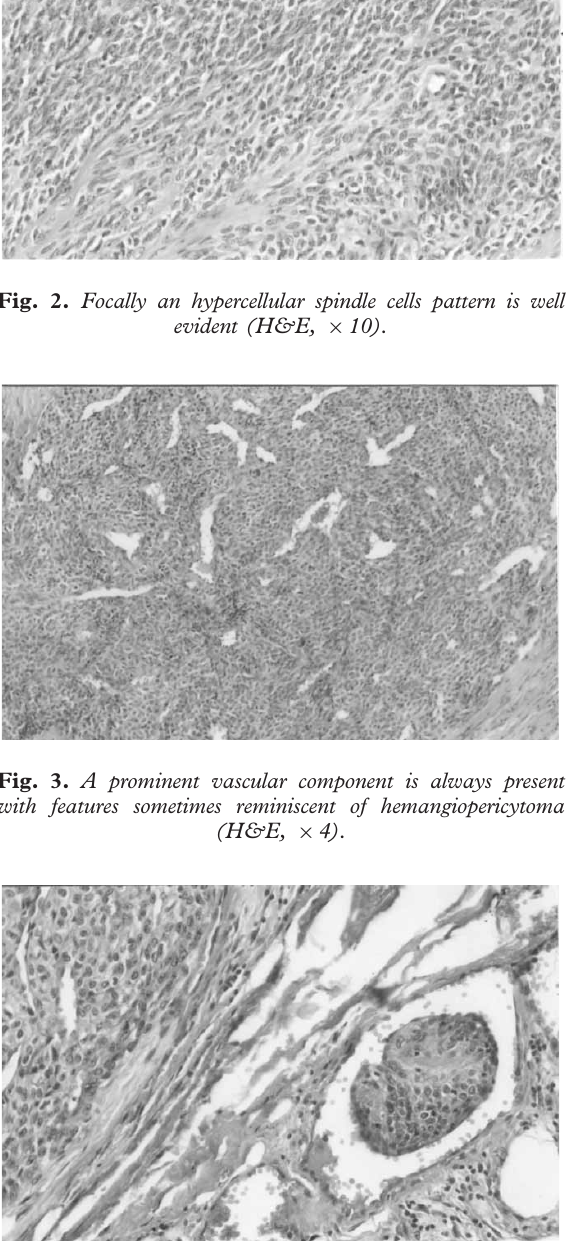
Fig. 4. The tumour (on left) presents clearly vascular space involvement (on right) (H&E, (cid:1) 10).